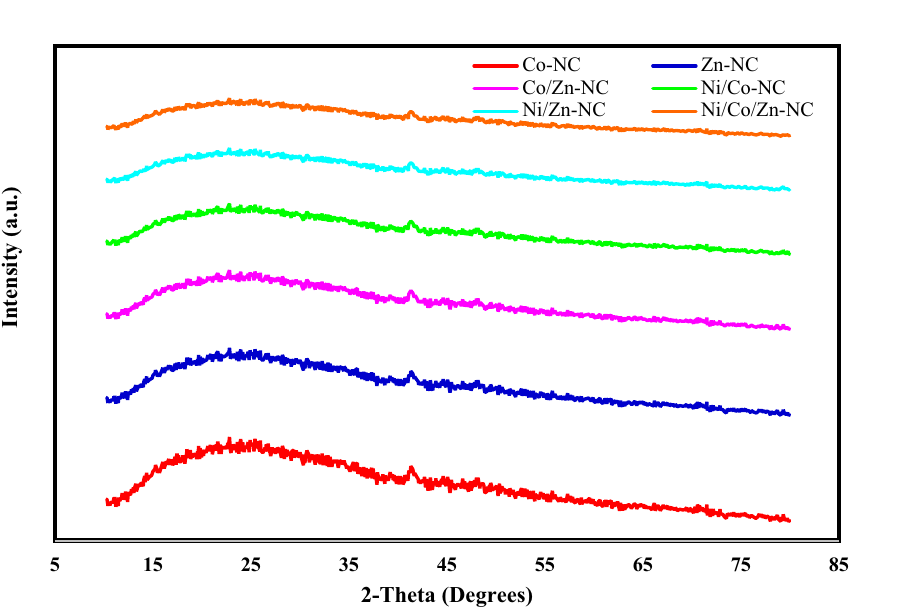
Figure 4. Powder XRD patterns of samples after carbonization